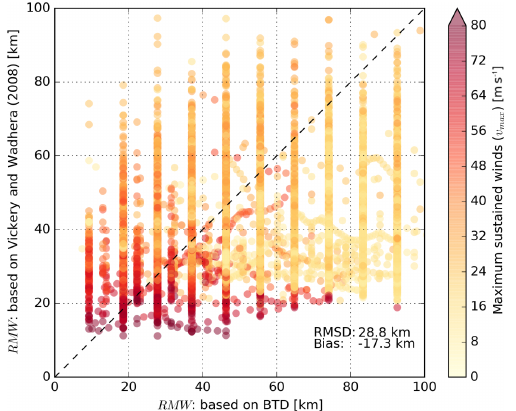
Figure 3. Scatter plot describing BTD RMW ( x axis) versus com- puted RMW based on VW08 ( y axis). Data points are colored- coded based on the maximum sustained wind speeds in the BTD. The dashed line represents a perfect fit between BTD and computed data based on VW08.